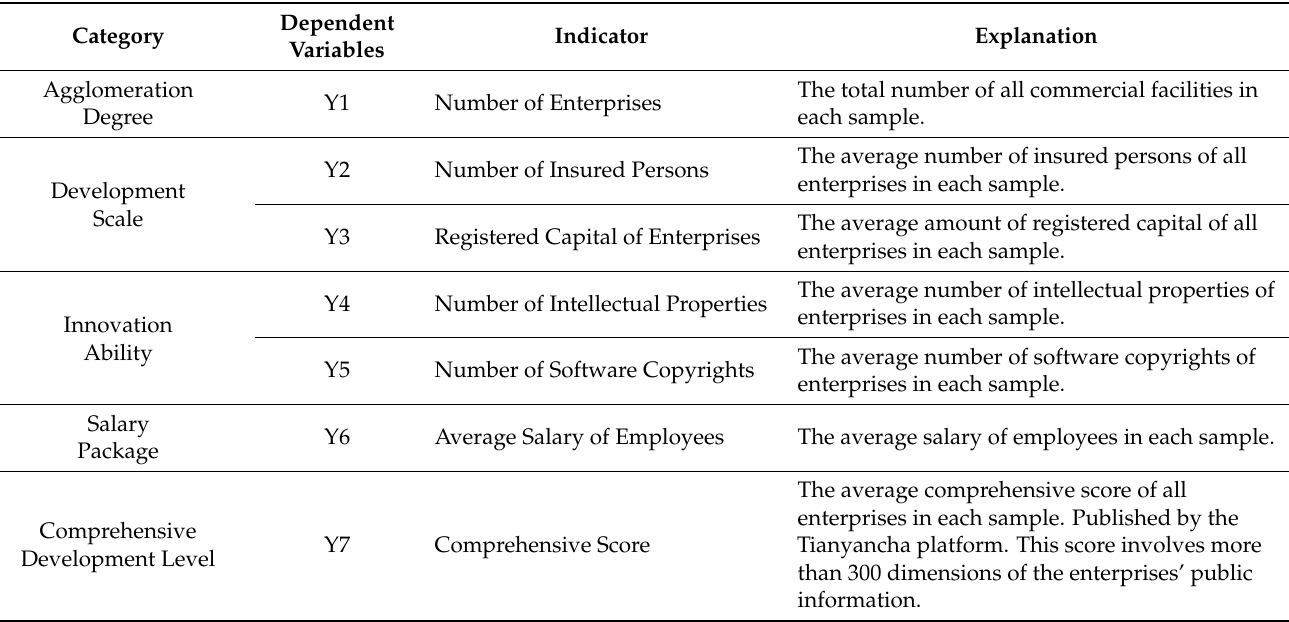
Table 5. Dependent